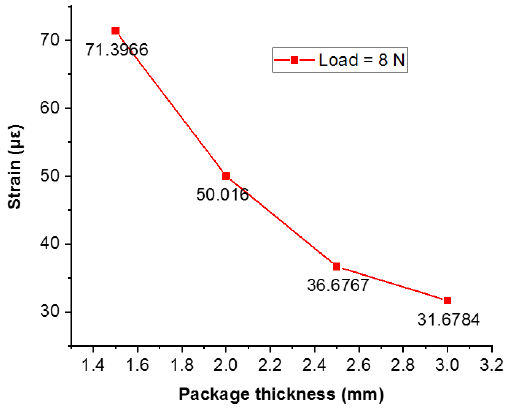
Figure 11. Strain curve diagram of the sensor packaging thickness.